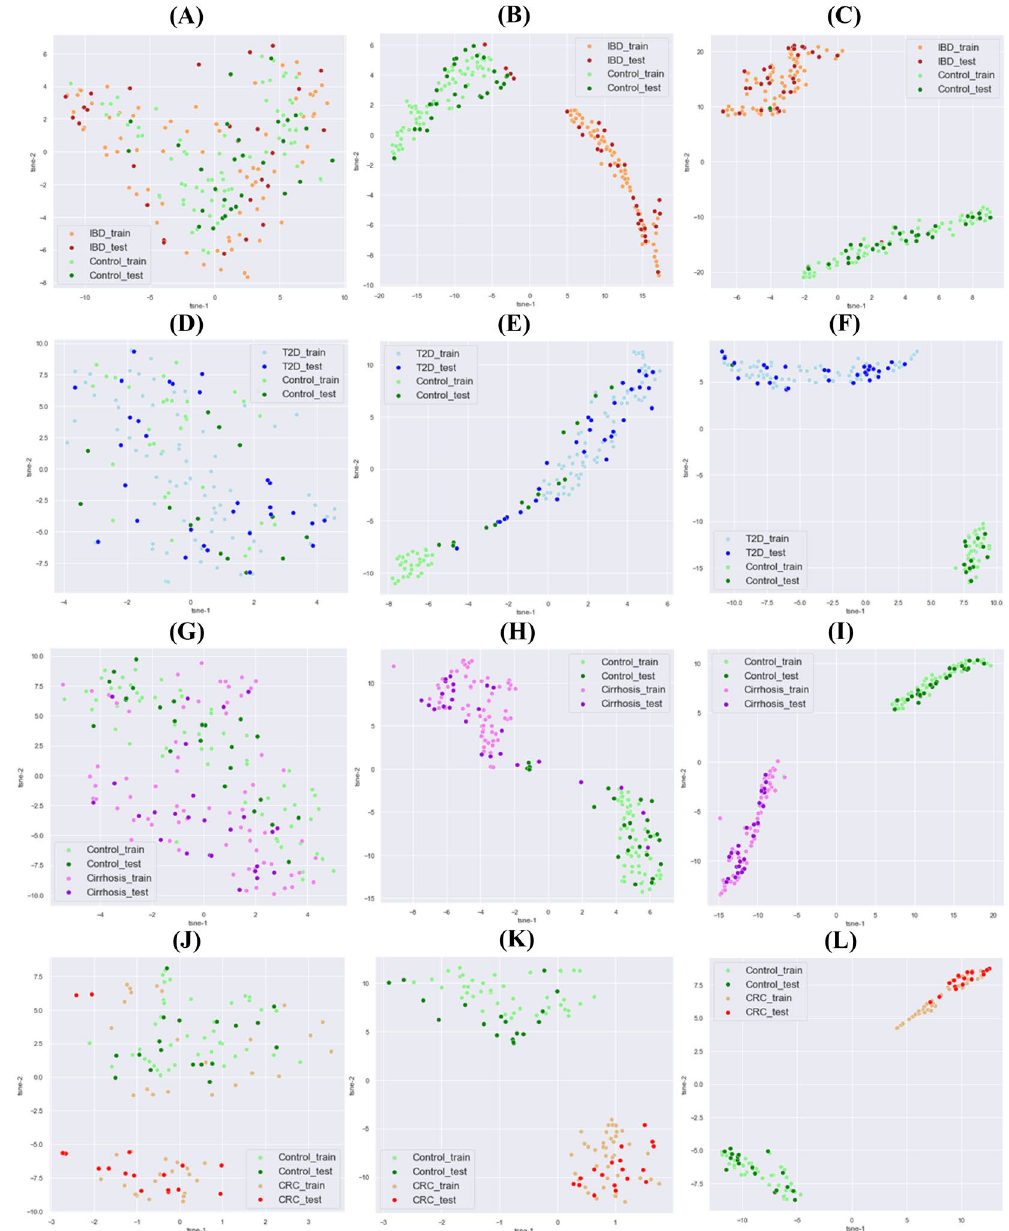
Figure 4. Visualizations of the IBD, T2D, and LC datasets before and after training using t-SNE. Each column, ( A–C ), ( D–F ), ( G–I ), and ( J–L ) was generated with IBD, T2D, LC, and CRC datasets, respectively. ( A,D,G,J ) are from the data before training MDL4Microbiome with all features combined (simply concatenated). ( B,E,H,K ) are from the data in the last hidden layer when the classifier was trained with 70% of the dataset (as light colors). The remaining 30% retained for testing were predicted using the classifier (as dark colors). ( C,F,I,L ) are the result of one-fold of LOOCV. All samples, except for one, in the dataset were used for training, and all samples were included in prediction for